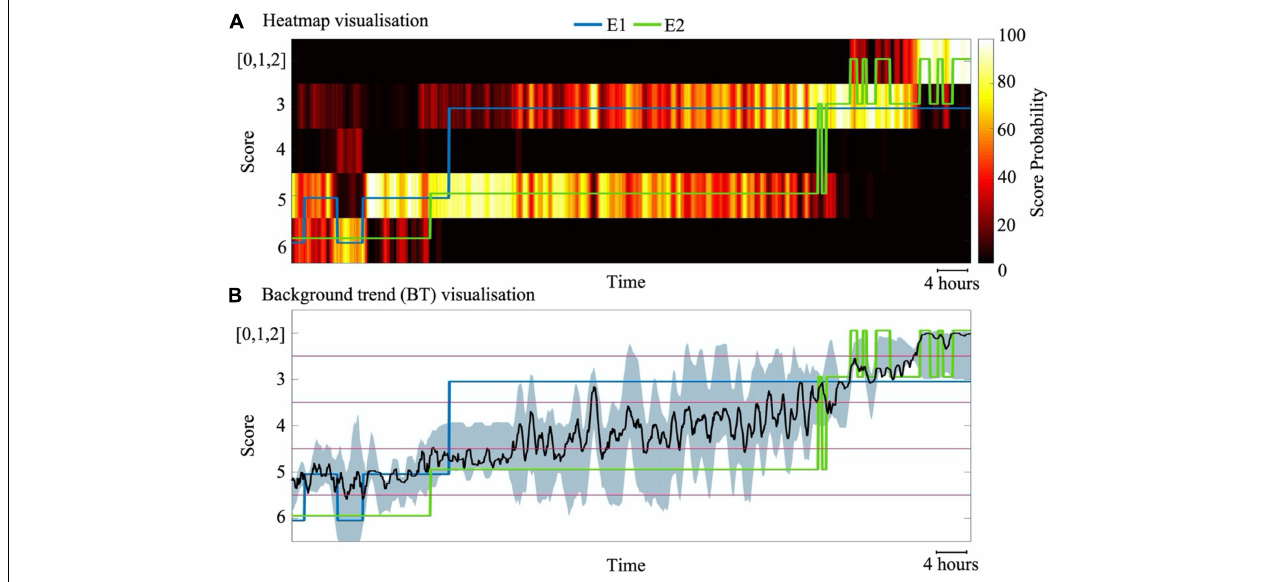
FIGURE 7 | Visualization of SVM classifier outputs for an example subject with 88 h of data. (A) A heatmap visualisation that depicts the time course of normalized probability for each score. (B) Visualization of a background trend (BT) shows the weighted average of probability values (black line) as well as the uncertainty of the classification at each epoch (grey shade). The blue and green lines indicate the individual annotations from experts E1 and E2, respectively.